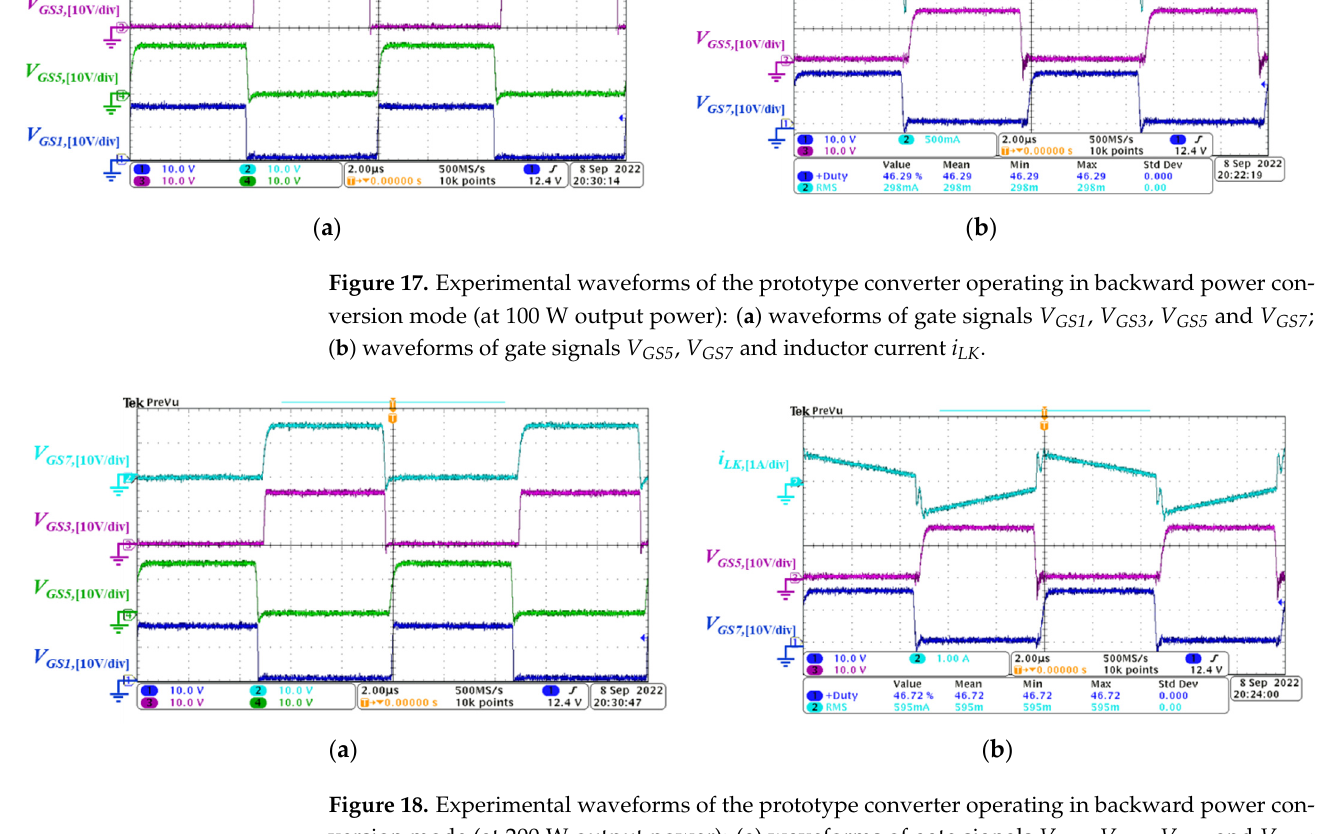
Figure 18. Experimental waveforms of the prototype converter operating in backward power con- version mode (at 200 W output power): ( a ) waveforms of gate signals V GS1 , V GS3 , V GS5 and V GS7 ; ( b ) waveforms of gate signals V GS5 , V GS7 and inductor current i LK .